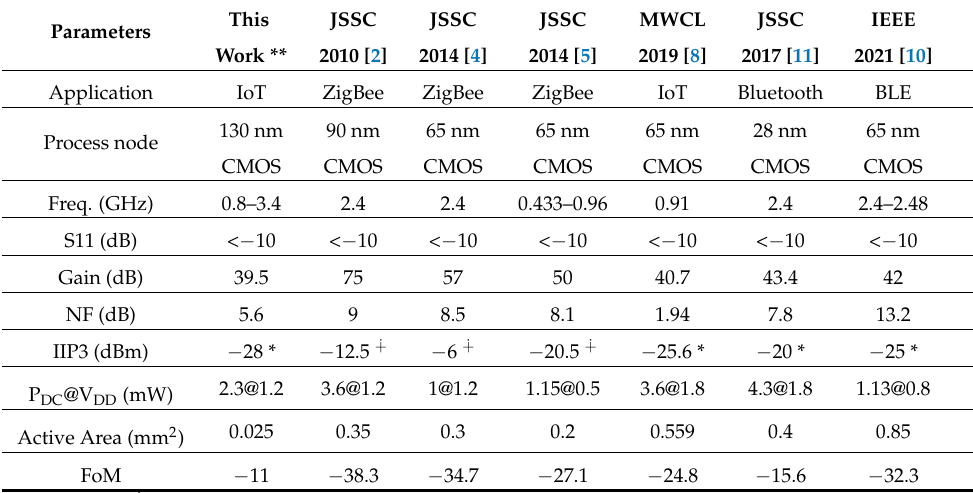
Table 1. Performance Summary and